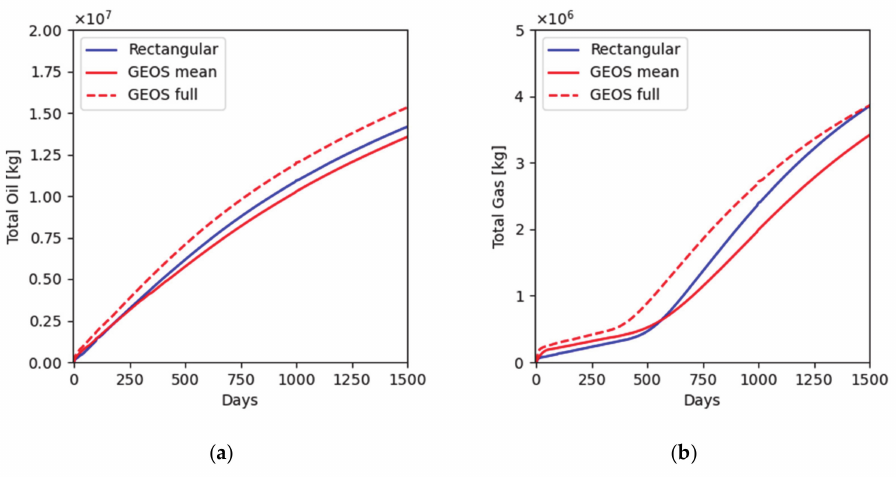
Figure 11. Cumulative oil ( a ) and gas ( b ) production for the three representations of the upscaled fracture. It is expected that increasing fracture aperture leads to increased production, but in the case of heterogeneous fractures—in which apertures vary by orders of magnitude over the extent of the fracture, resulting in the creation of heterogeneous flow pathways within the fracture—the net effect on production remains unclear. The present results qualitatively emphasize the impact of fracture shape and aperture heterogeneity on oil production,